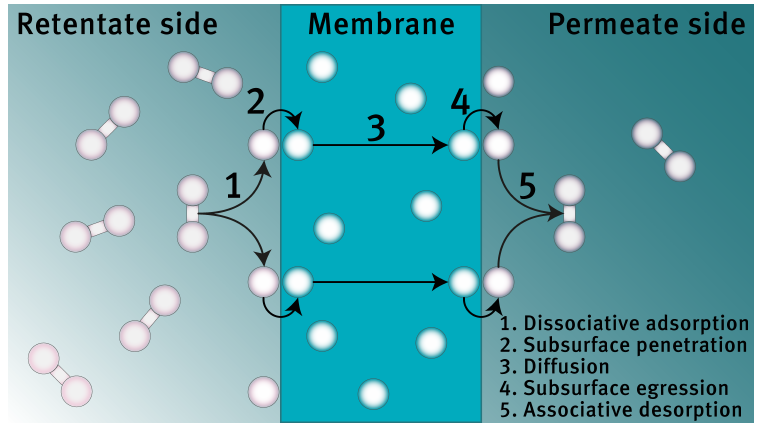
Figure 1. Schematic representation of the five-step permeation